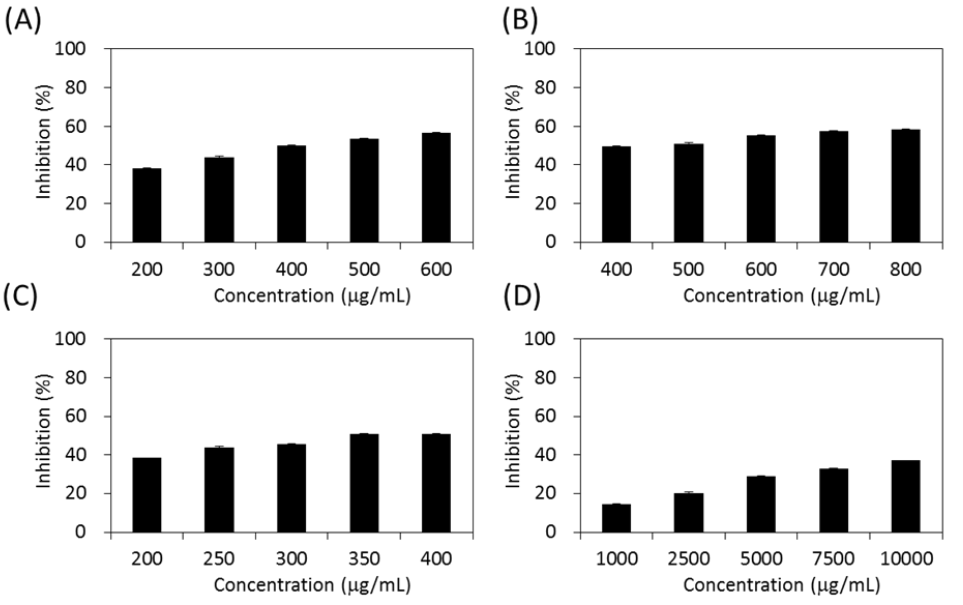
Figure 4. Inhibitory activities of S. orientalis extracts on α -glucosidase. ( A ) SE; ( B ) SE-Hex; ( C ) SE-EA; and ( D ) SE-MeOH.